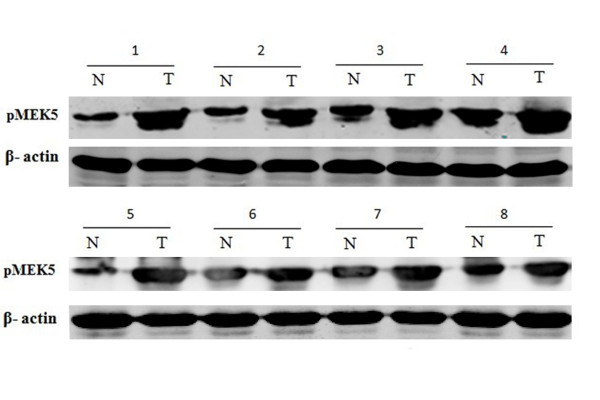
Western blot analysis of pMEK5 protein expression. Western blot analysis of pMEK5 proteins expressed in eight pairs represents colorectal tumor tissues (T) and their matched adjacent nontumor tissues (N). Expression level was normalized with β-actin.